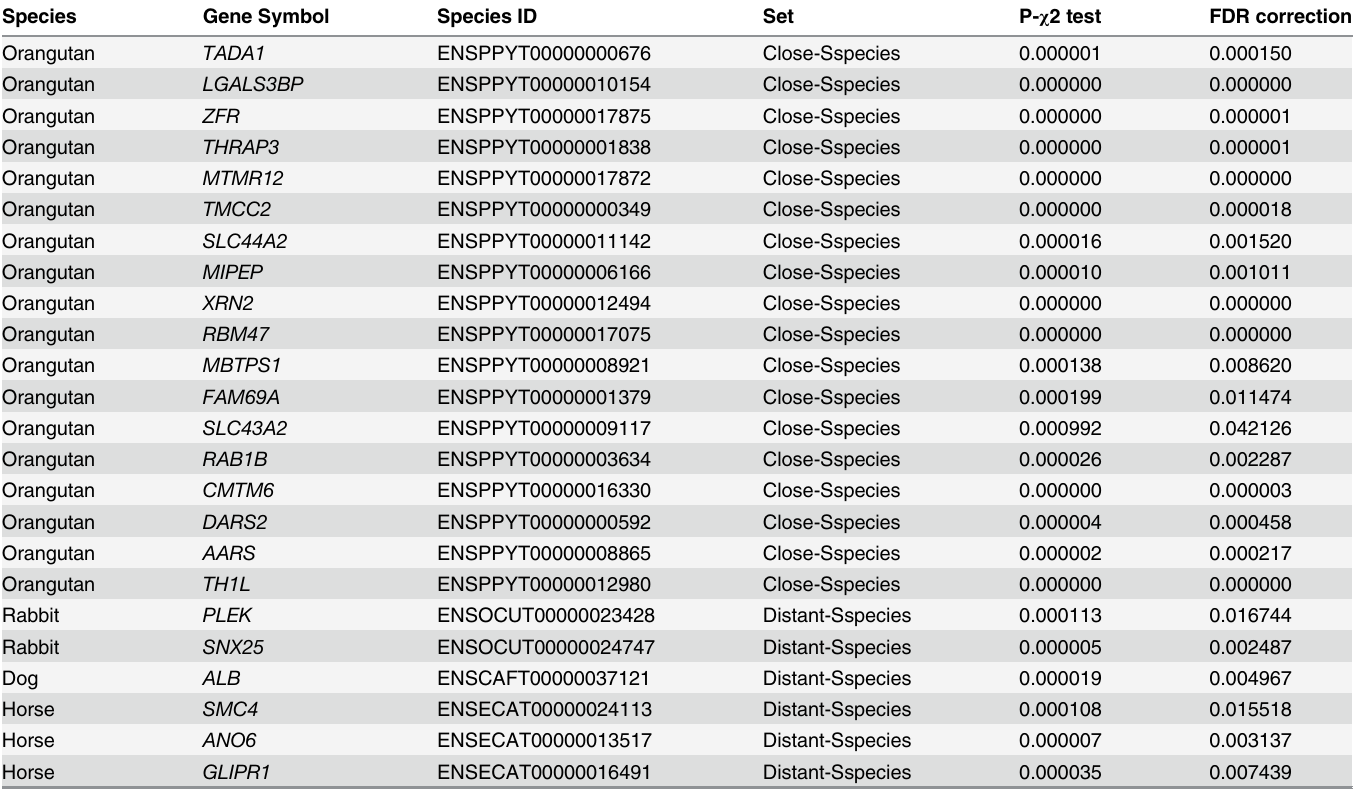
Table 4. Positively-selected genes in seasonal species filtered by SP scoring and corrected by cDNA